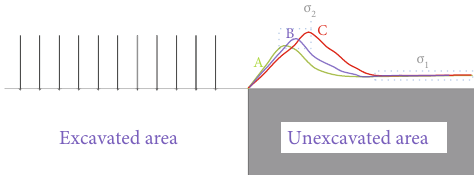
Figure 10: Evolution law of advanced abutment stress in front of heading face caused by roadway